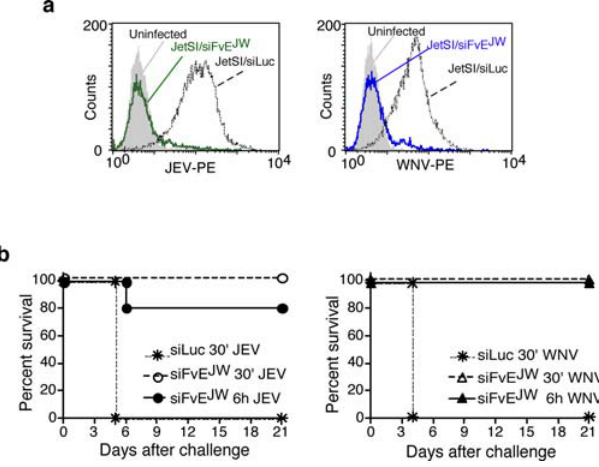
Figure 4. FvE JW Protects against Encephalitis Induced by Either JEV or WNV (A) FvE JW siRNA inhibits both JEV and WNV infection in Neuro 2a cells. siRNA-treated Neuro 2a cells were challenged with a MOI of ten of either JEV (left) or WNV (right) and examined for viral replication by flow cytometry 72 h postinfection. Included is an overlay histogram of uninfected Neuro 2a cells and JEV- or WNV-infected Neuro 2a cells transfected prior to infection with either JetSI/DOPE/siLuc or JetSI/DOPE/ siFvE JW as indicated. (B) FvE JW siRNA protects mice against both JEV and WNV-induced encephalitis. Mice were injected IC with four LD 50 of JEV (left) or WNV (right), and after 30 min or 6 h they were also injected at the same spot with 3.2 nmoles of either siLuc or FvE JW complexed with JetSI/DOPE and monitored for survival over time. Ten and five mice per group were used to test the effect of siRNA 30 min and 6 h postinfection, respectively. DOI: 10.1371/journal.pmed.0030096.g004